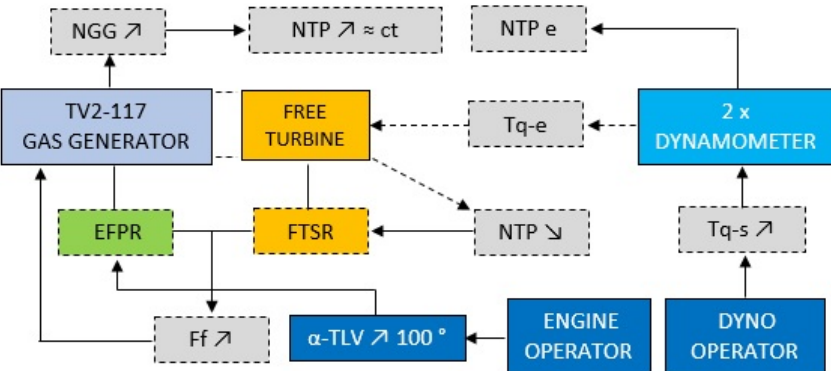
Figure 6. Engine fuel control and engine operation law